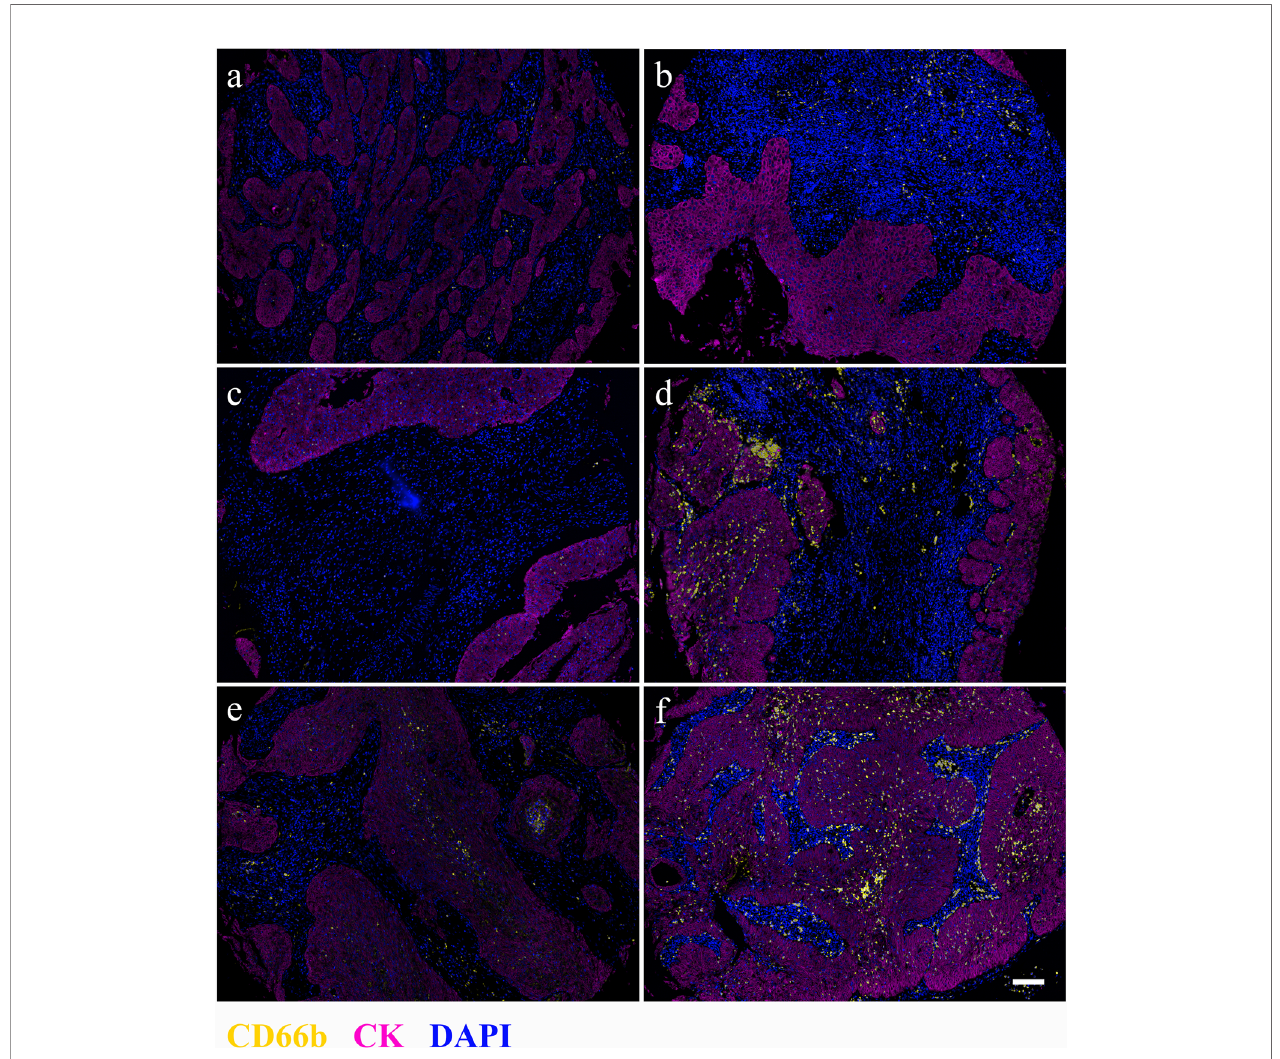
FIGURE 1 | Distribution of CD66b + cells in stromal (A, B) , tumor nest (C, D) , and whole tissues of cervical cancer samples. Left (A, C, E) , low CD66b density; right (B, D, F) , high CD66b density. Magni fi cation 4×, scale bar = 100 m m. CD66b, yellow; CK, magenta; DAPI,